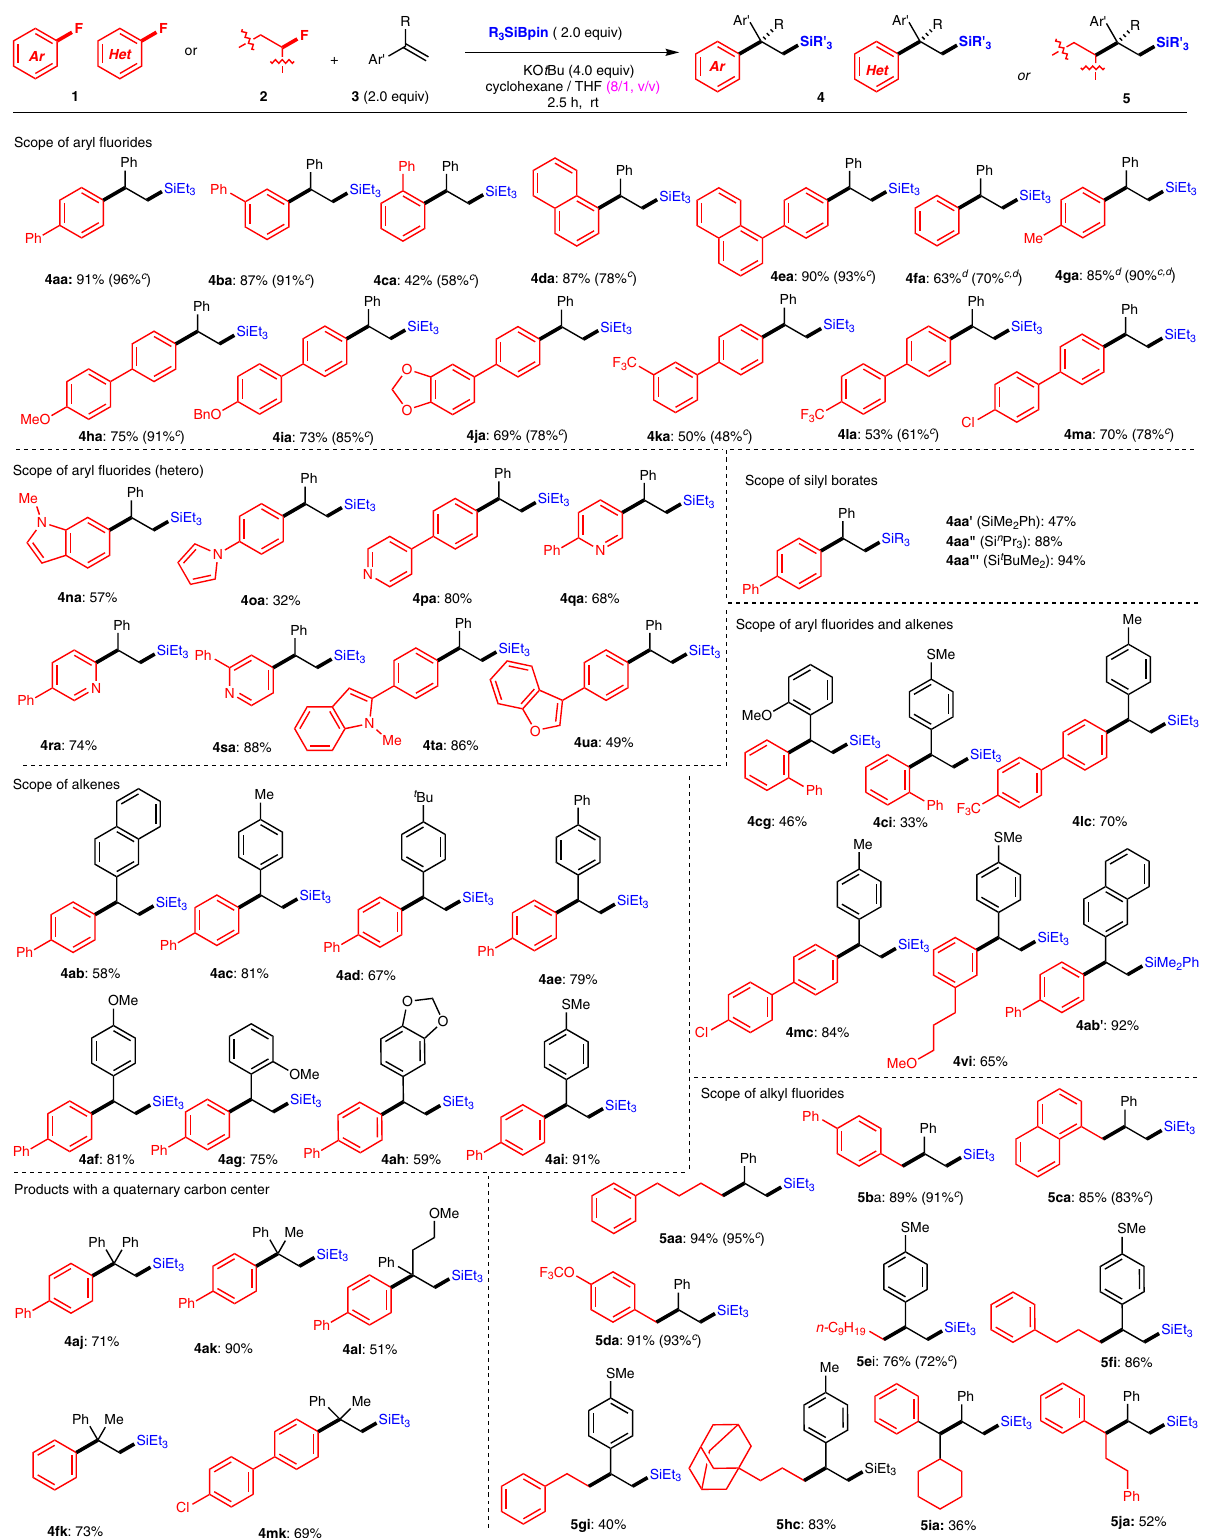
Fig. 2 Carbosilylation of alkenes with silyl boronates and aryl/alkyl fl uorides a, b . a The reaction was carried using 1 or 2 (0.2 mmol), 3 (2.0 equiv.), Et 3 SiBpin, Me 2 PhSiBpin, n Pr 3 SiBpin or t BuMe 2 SiBpin (2.0 equiv.), and KO t Bu (4.0 equiv.) in cyclohexane/THF (1.5 mL, 8/1, v/v) at room temperature. b Isolated yield is shown. c The reaction was carried out in the presence of Ni(COD) d 0.4 mmol of 1 was 2 (1.0 mol%).